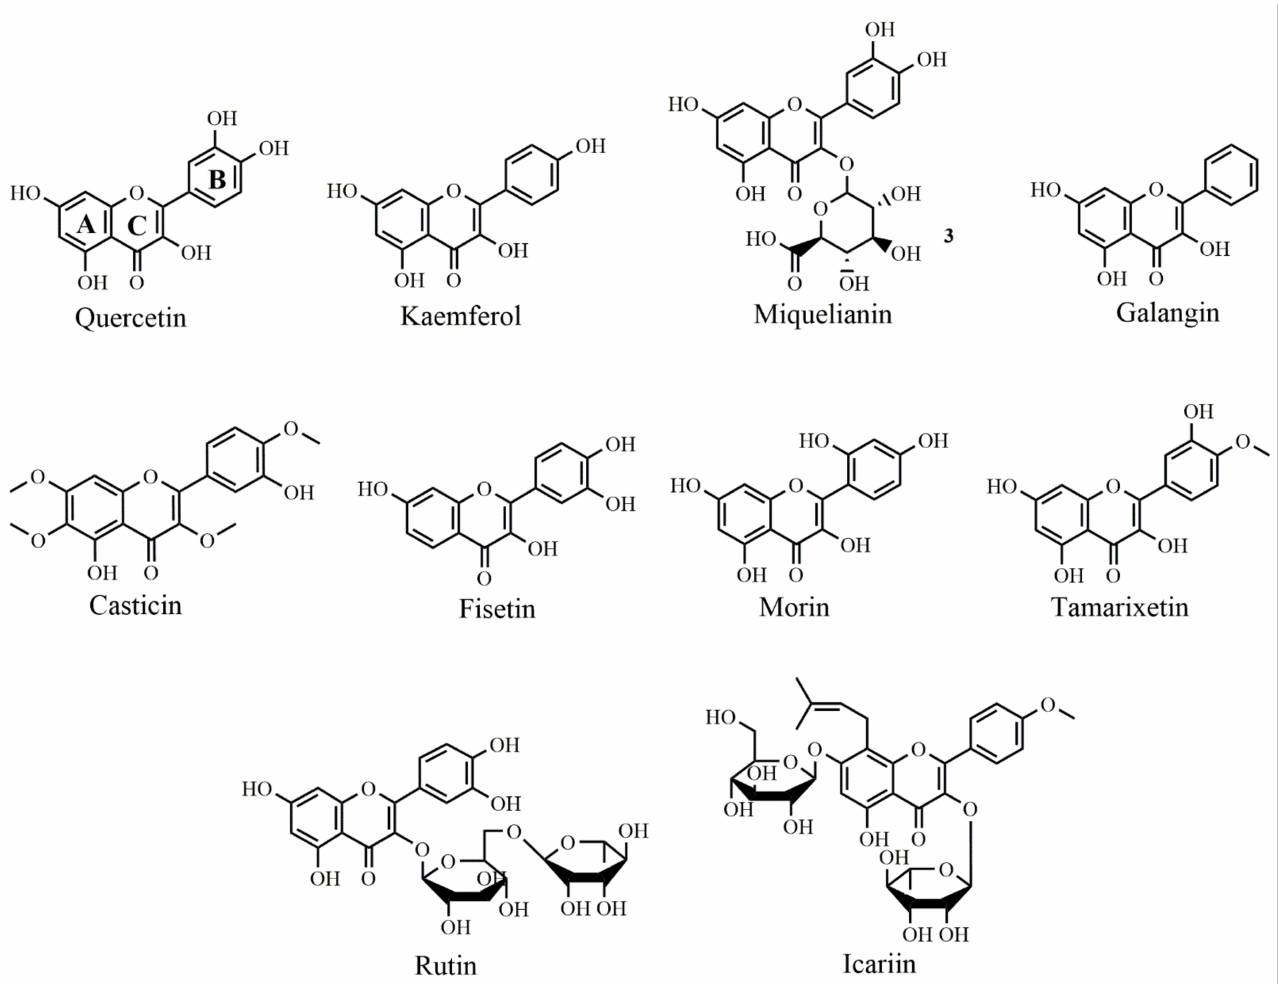
Figure 2. Selected chemical structures of flavonols targeting Bcl-2 in the p53 pathway. Two benzene rings ( A and B ) connected via a heterocyclic pyran ring ( C